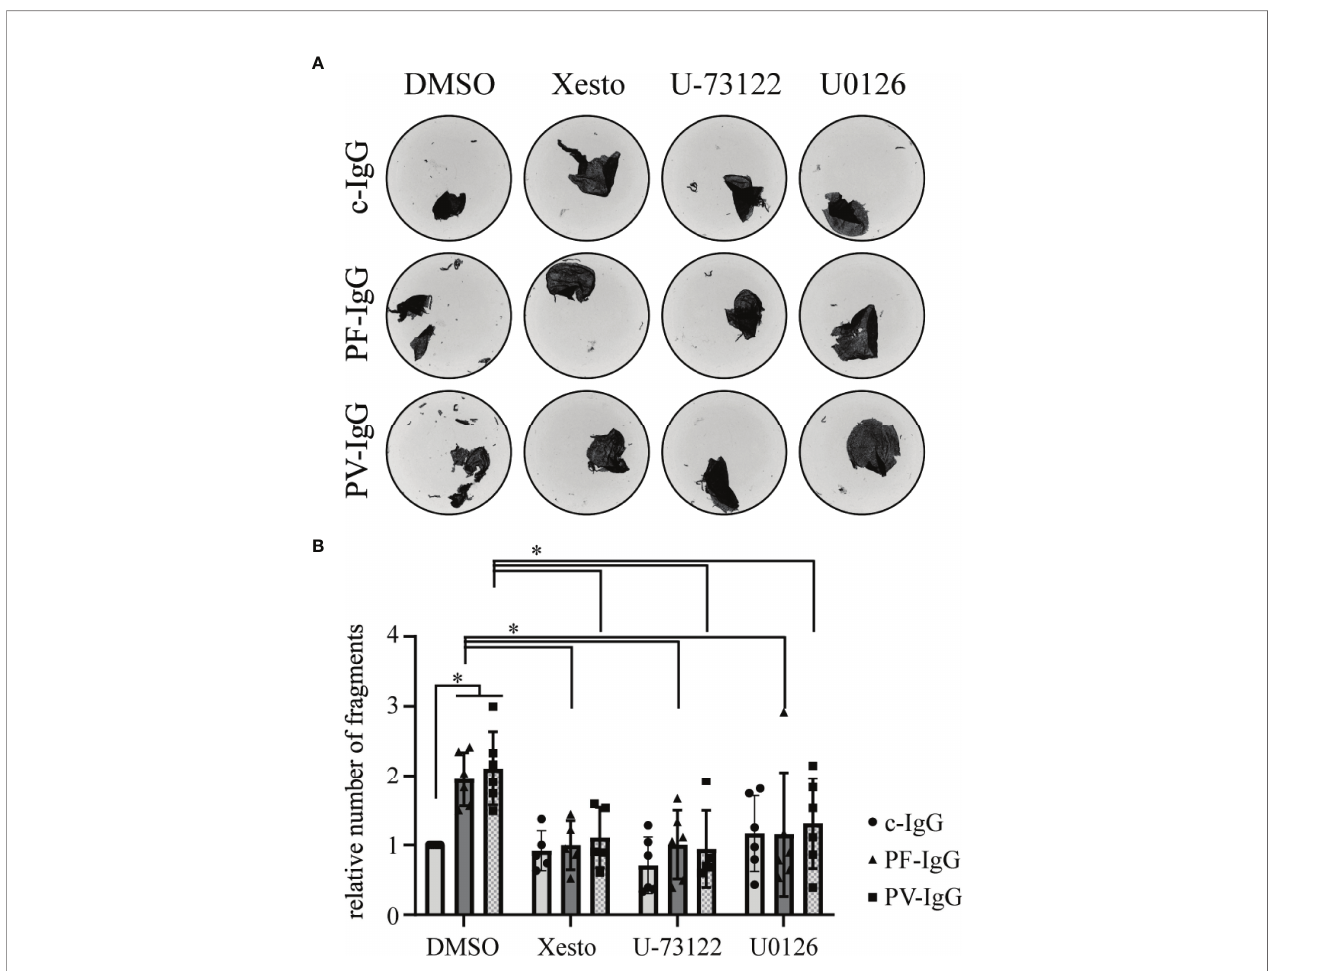
FIGURE 1 | Pemphigus autoantibody induced loss of cell cohesion can be ameliorated by inhibition of Ca 2+ and ERK1/2 signaling; (A) Representative images of monolayer fragments after the application of shear stress of dispase-based dissociation assays of HaCaT cells after 24 h incubation with IgG fractions and mediators. (B) Corresponding quanti fi cation to (A) ; the number of fragments in each experimental condition has been normalized to the DMSO c-IgG value. N ≥ 5; each dot represents one independent experiment. *P < 0.05 in two-way ANOVA; error bars represent standard